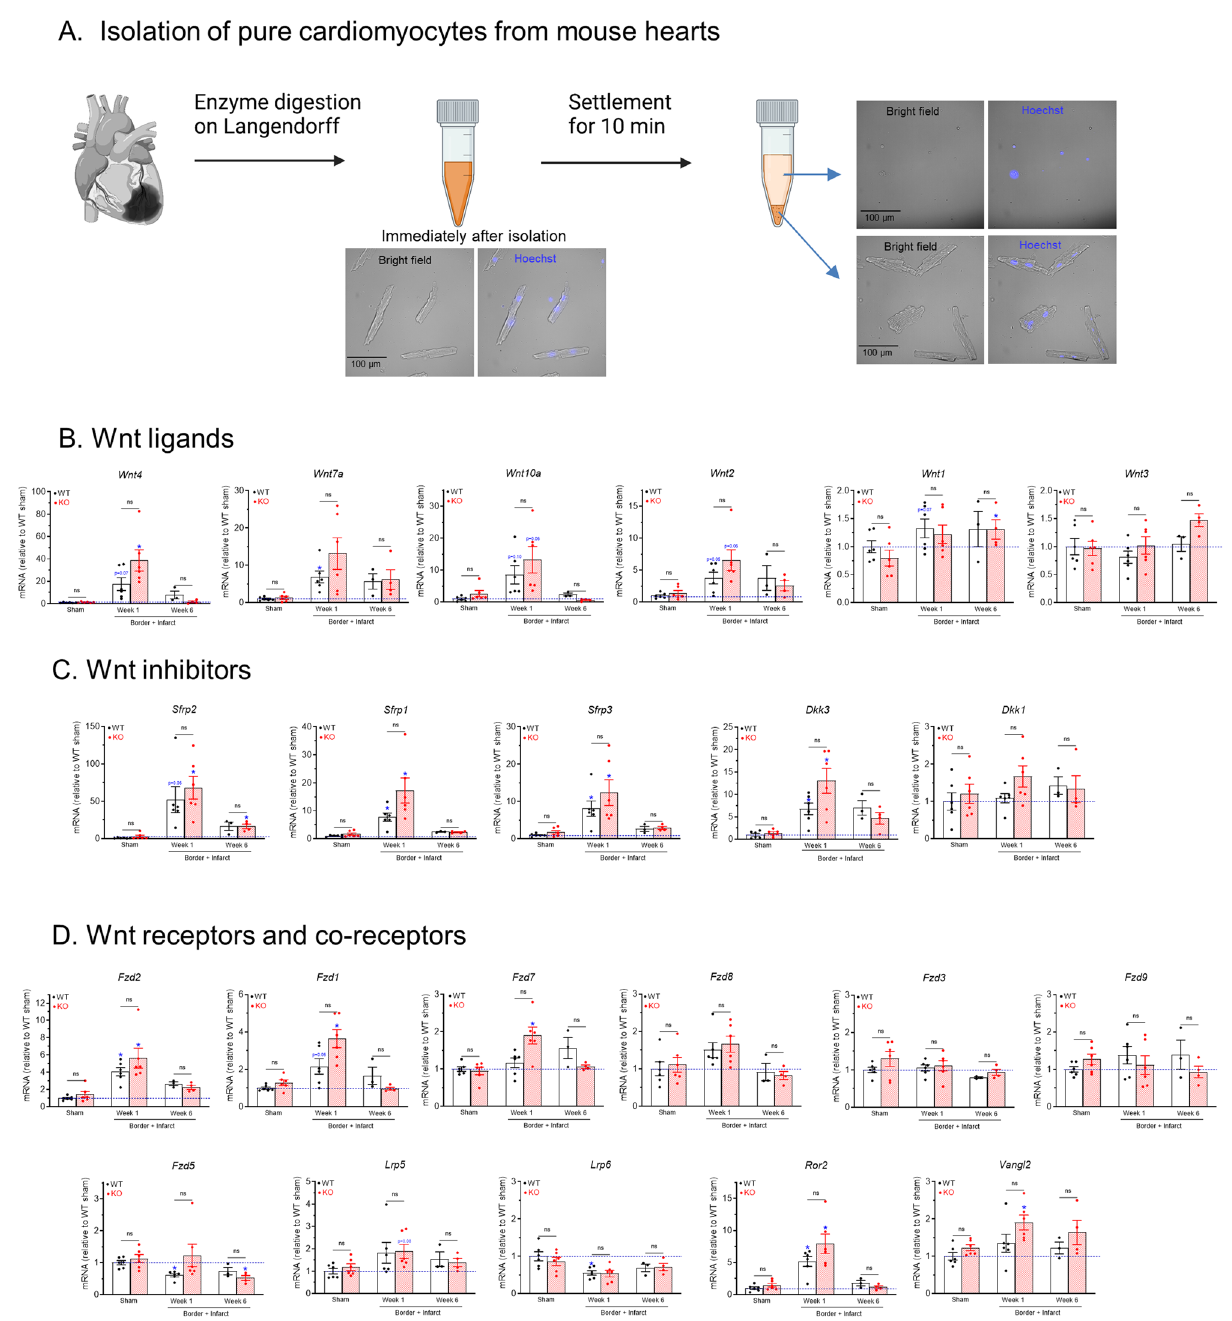
Figure 7. Upregulation of Wnt pathway genes in purified cardiomyocytes after myocardial infarction. ( A) Isolation of pure cardiomyocytes from mouse hearts. Mouse hearts were digested with collagenase on a Langendorff perfusion system. The infarct and border region (or the left ventricular free wall in sham groups) were dissected, cut into small pieces, and gently pipetted to release single cells. The cell suspension contained both cardiomyocytes (rod-like cells) and other cell types (the Hoechst-positive small round cells), which can be separated by their different settlement speed: after a 10-min settlement, the cardiomyocytes were enriched in the pellet while the other cell types (non-cardiomyocytes) remained in the supernatant. The pellet containing pure cardiomyocytes was used for RNA extraction and qPCR analysis. The Hoechst-negative small particles are likely cell debris. ( B) to (D) qRT-PCR analyses of transcript levels of Wnt ligands ( B ), Wnt inhibitors ( C ) and Wnt receptors and coreceptors genes ( D ) in pure cardiomyocytes isolated from sham, 1-week post MI, and 6-week post MI infarct and border zone. n = 3–6 per group. * p < 0.05 vs. corresponding sham groups. “ns” means no significant difference between WT and KO groups. Data were analyzed by two-way ANOVA and Bonferroni post-hoc